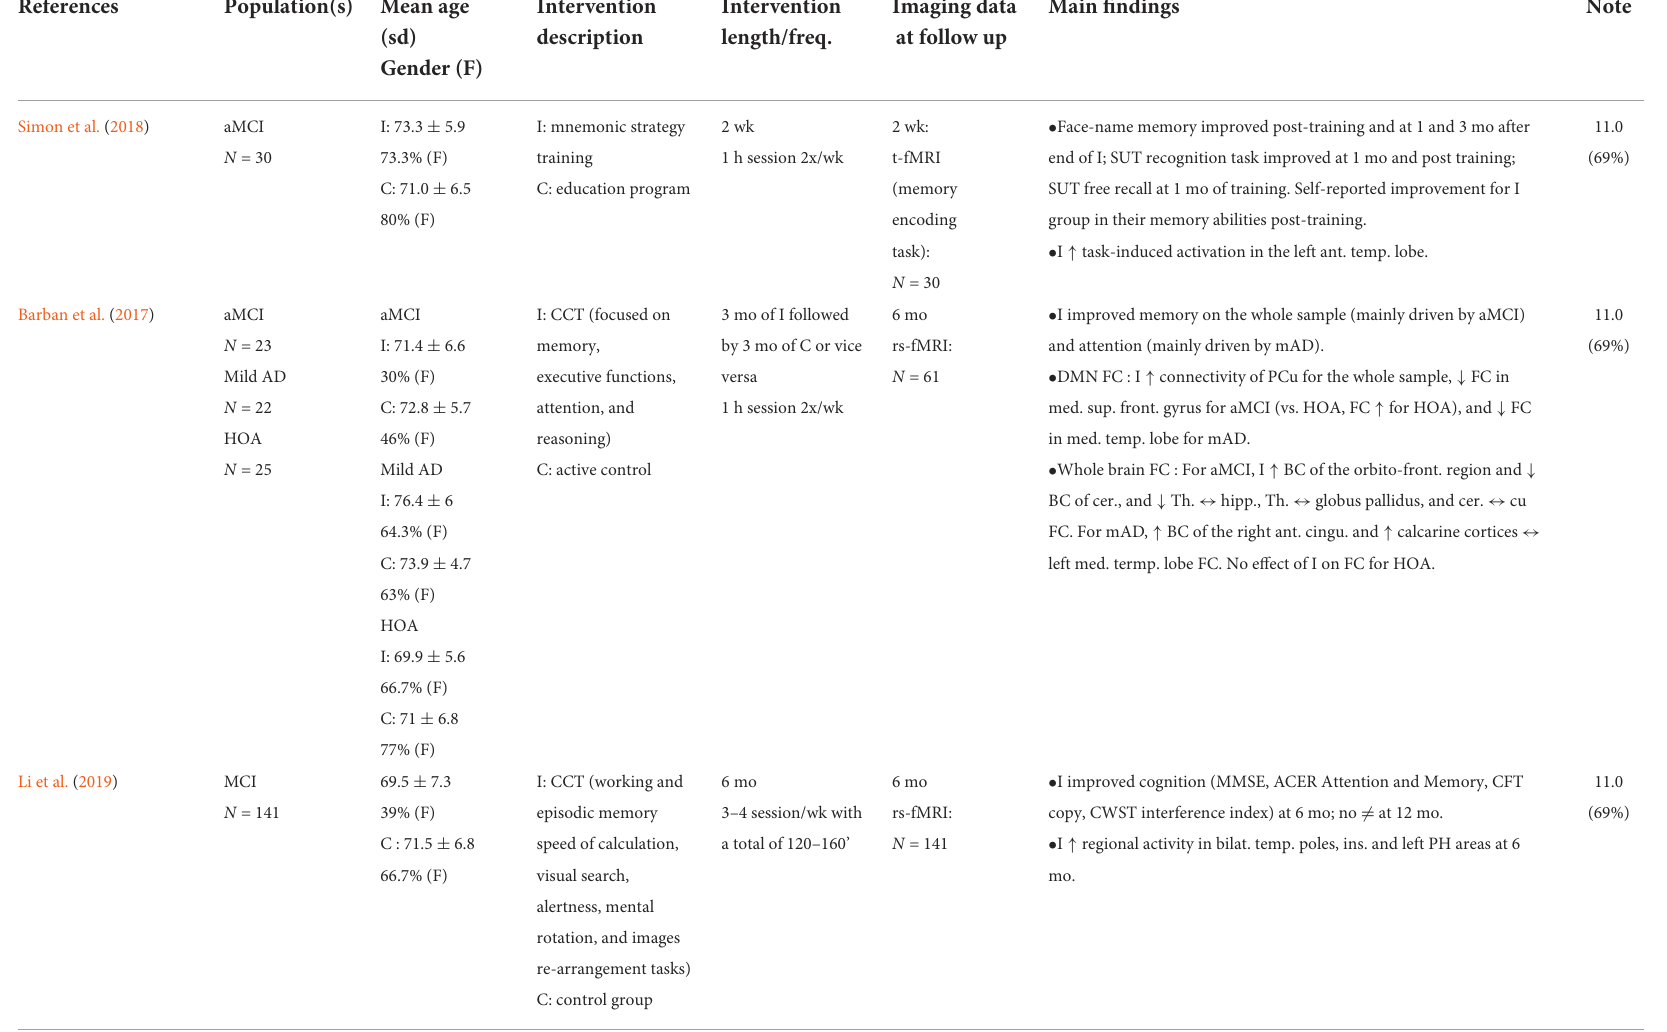
TABLE 7 Cognitive training (CT)